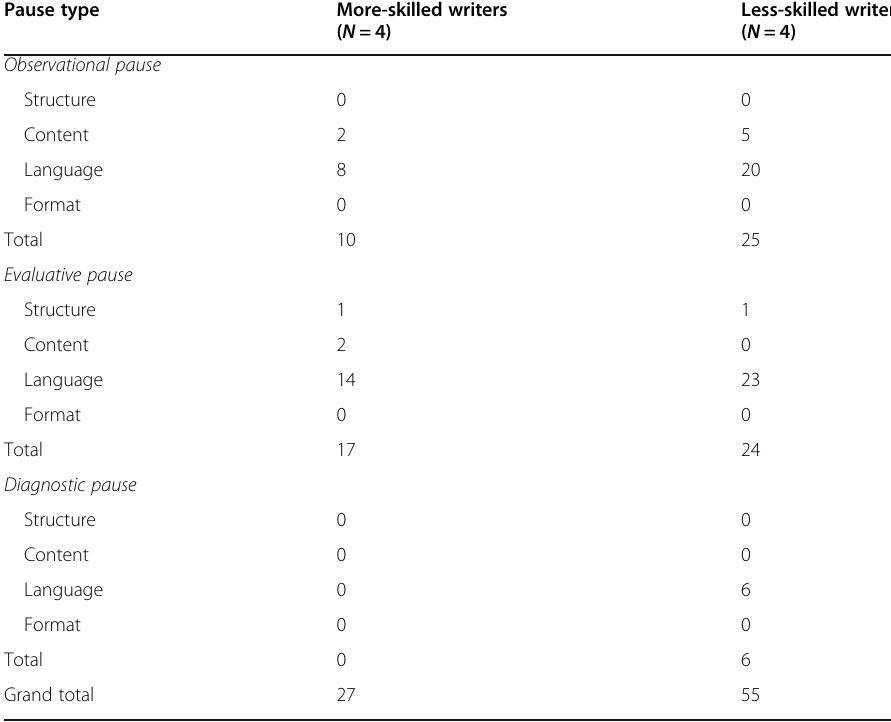
Table 6 Types of pauses made by more- and less-skilled EFL writers Pause